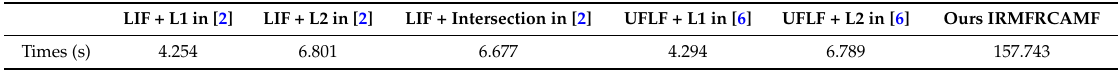
Table 11. Affinity matrix construction times of different methods from